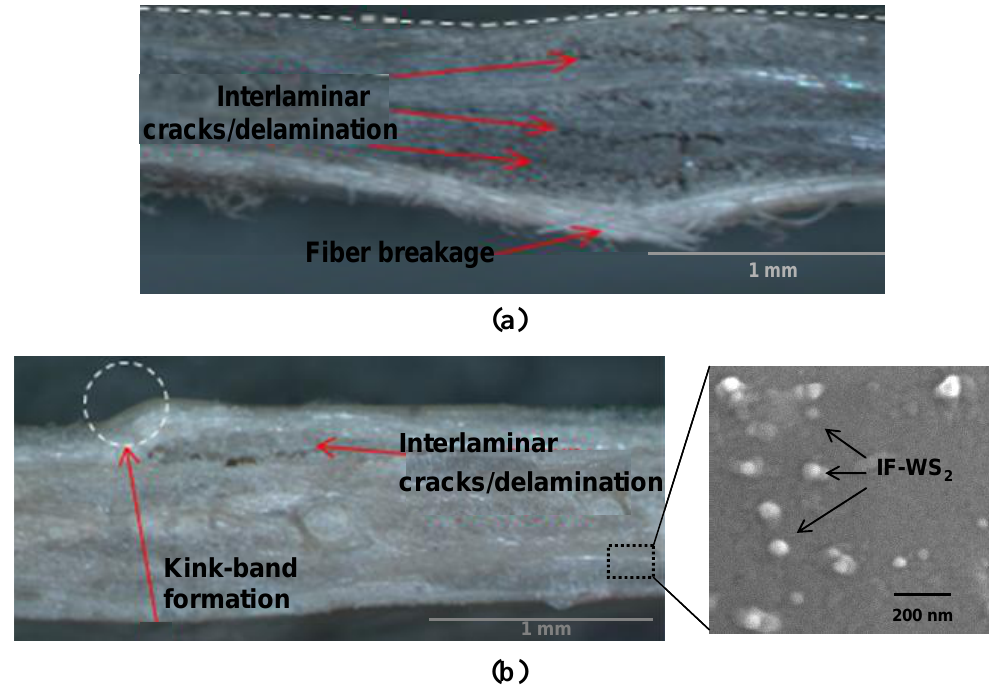
(1.0 wt %)/CF laminate. 2 nanoparticles. 2